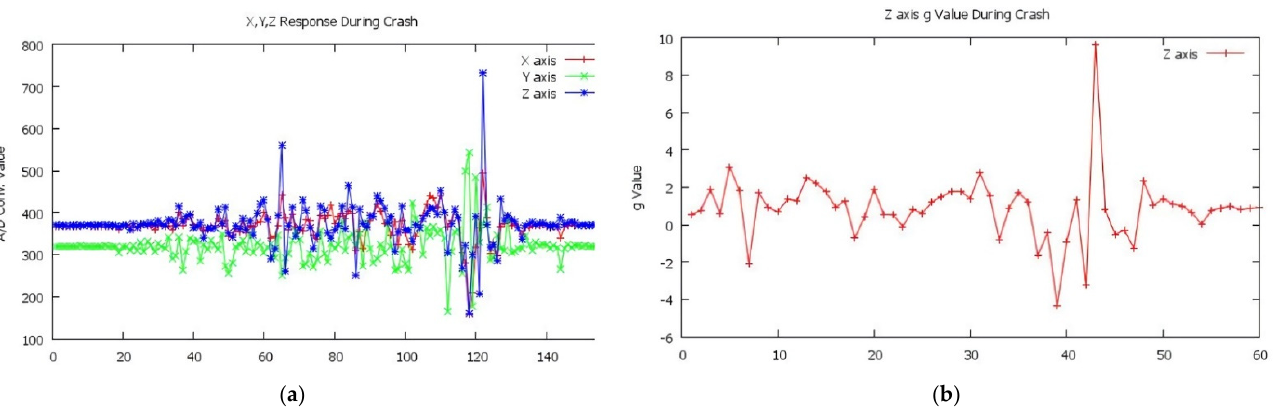
Figure 8. Testing accident with remote control car.